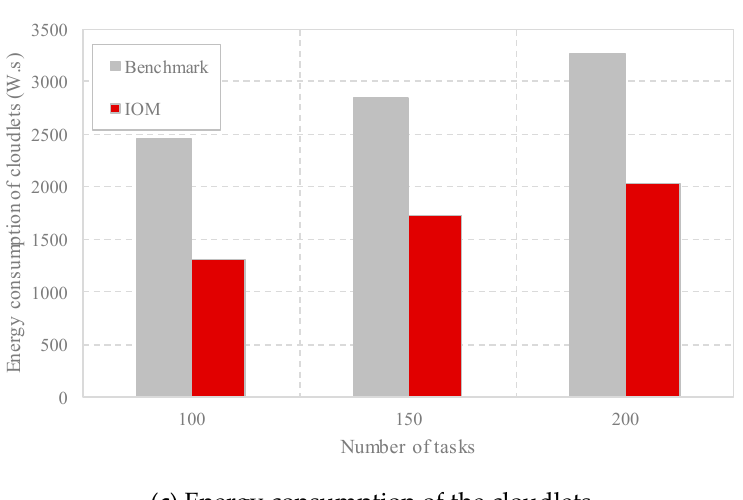
Figure 7. Comparison of the different components of the energy consumption with different task scales by Benchmark and IOM.